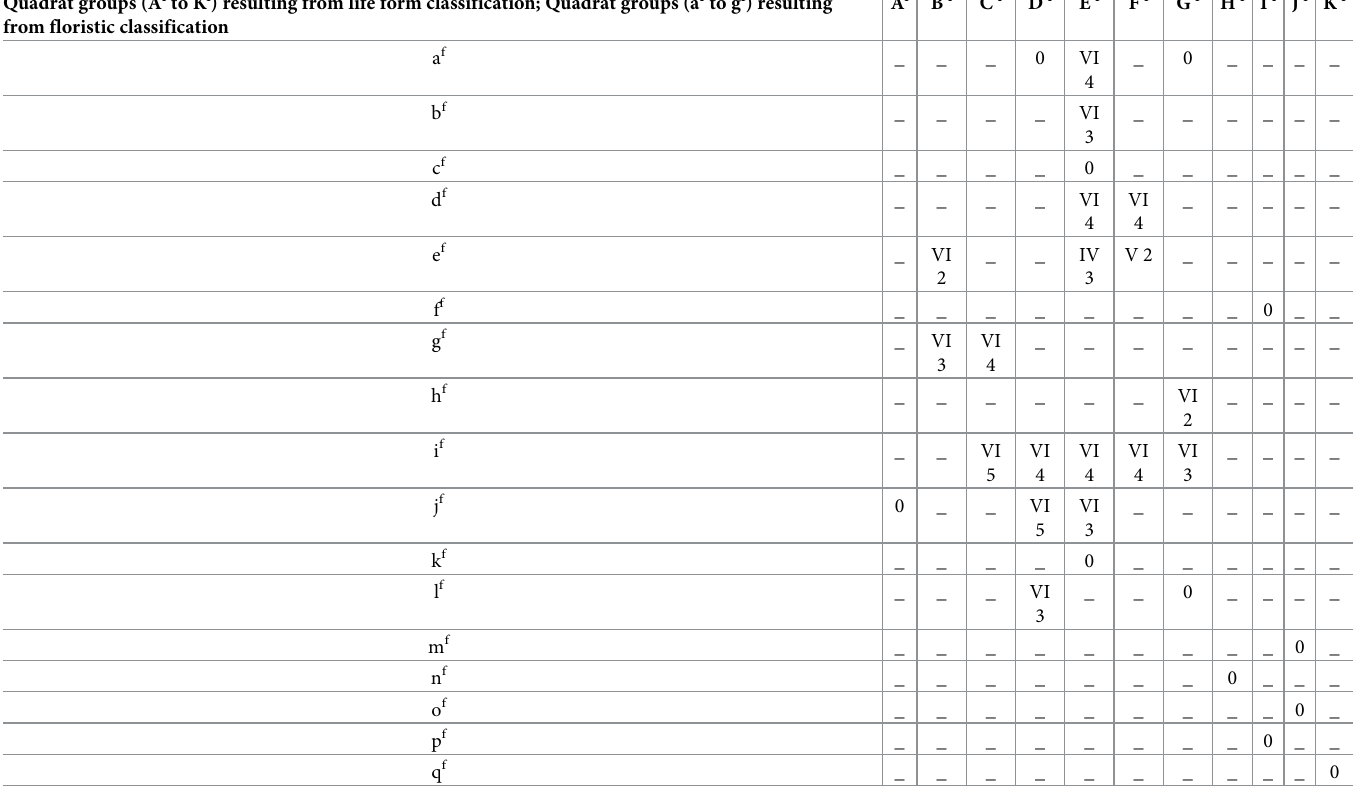
Table 2. Matrix of floristic and life-form classifications of quadrats from plant data set collected in Ras Beirut and southern part of the promontory of Beirut. Intersections show M . crassifolia represented by constancy and abundance and help define favorable and unfavorable vegetation assemblages. Quadrat groups (A l to K l ) resulting from life form classification; Quadrat groups (a f to g f ) resulting from floristic